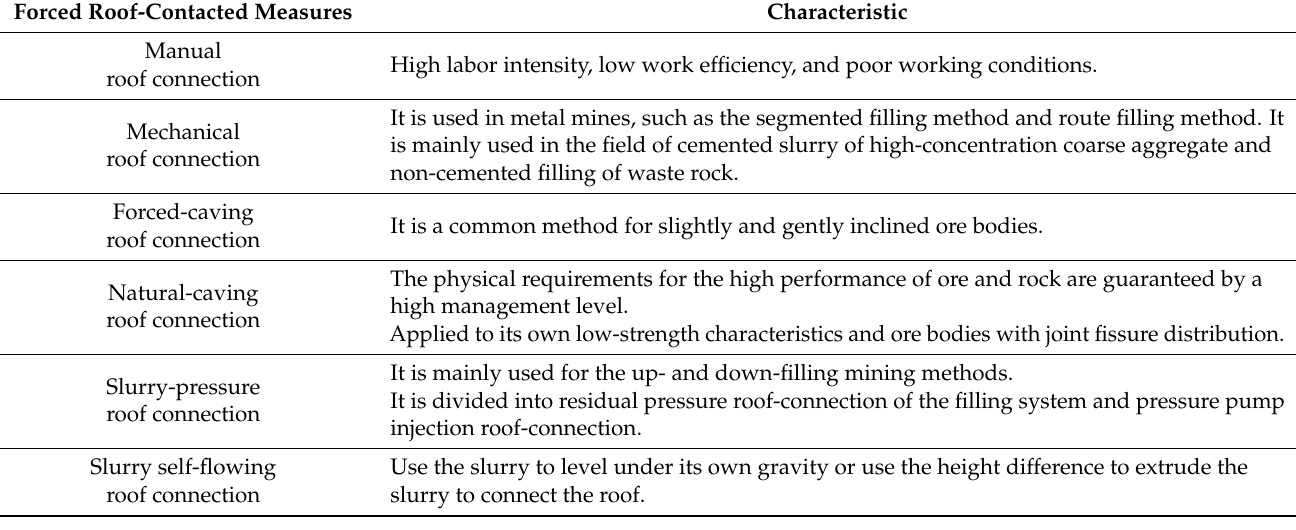
Table 2. Partial improvement measures.